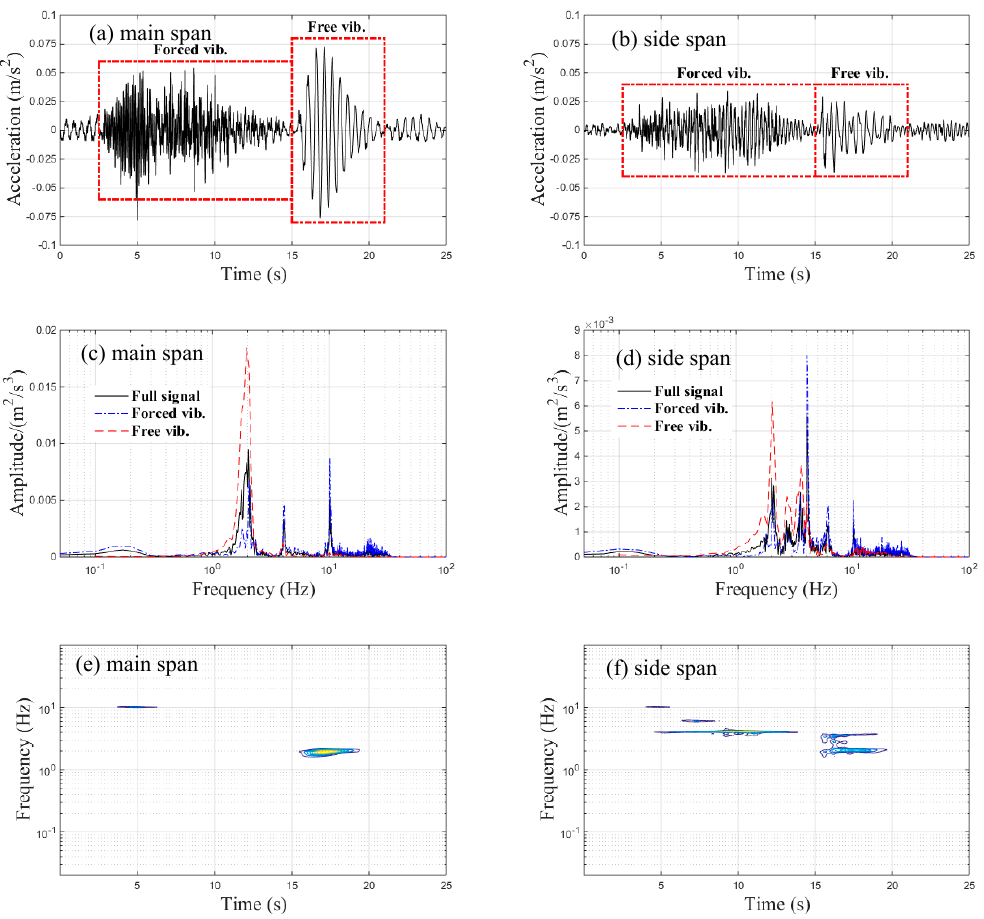
Figure 6. Vertical acceleration signals of the bridge during braking: ( a ) time-history data of the main span; ( b ) time-history data of the side span; ( c ) FFT results of the main span; ( d ) FFT results of the side span; ( e ) time–frequency representation results (TFRs) of the main span; ( f ) TFRs of the side span.